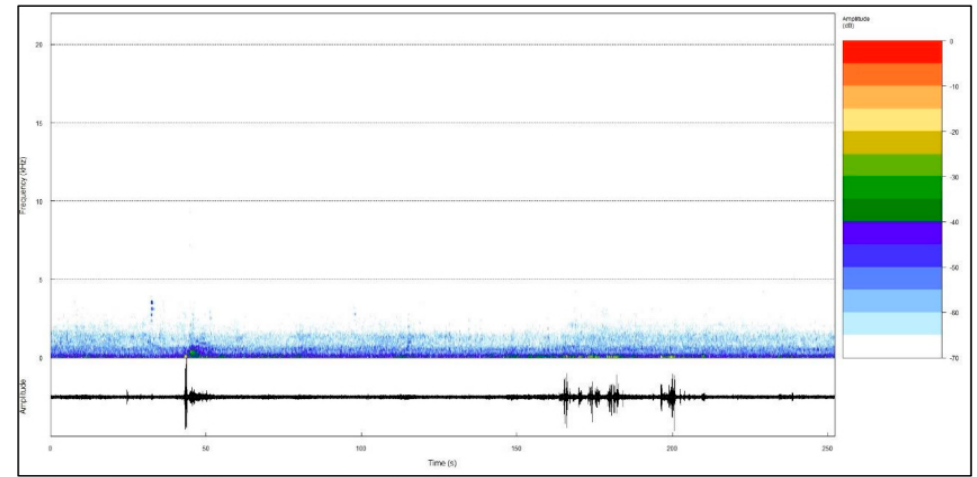
Figure 4. The spectrogram analysis of the Roman Agora sound recording. The low-frequency sounds were visible.